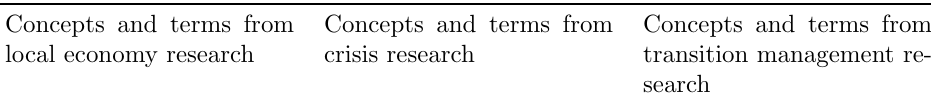
Concepts and terms from transition management re- search levance of the local level focus on the develop- ment and diffusion of in-